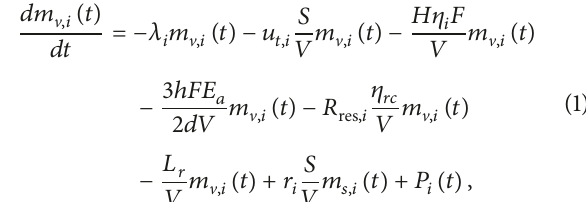
assumed to malfunction, which could result in core